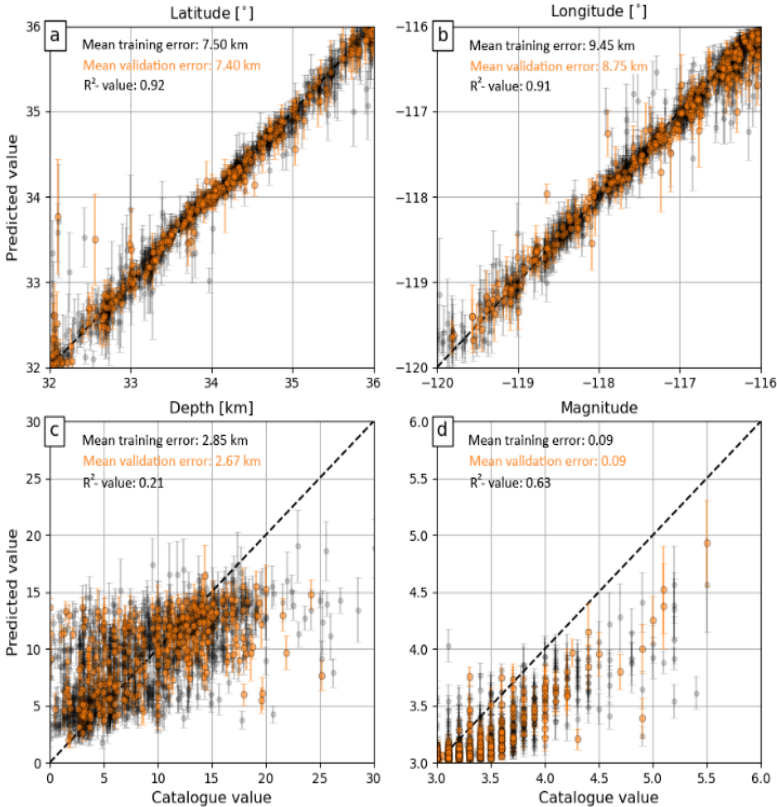
Figure 7. Mean absolute error for training and validation sets obtained from the California dataset. Predicted values by the BNGCNN model and the actual values for ( a ) latitude, ( b ) longitude, ( c ) depth, and ( d ) magnitude by inserting geographical information.